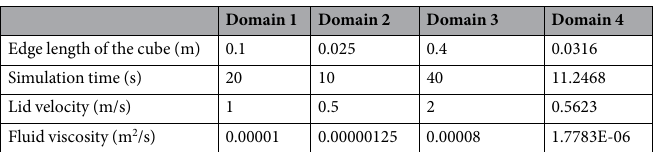
Table 4. Summary of the simulation characteristics for the original domain (Domain 1) and its self-similar domains (Domains 2, 3, and